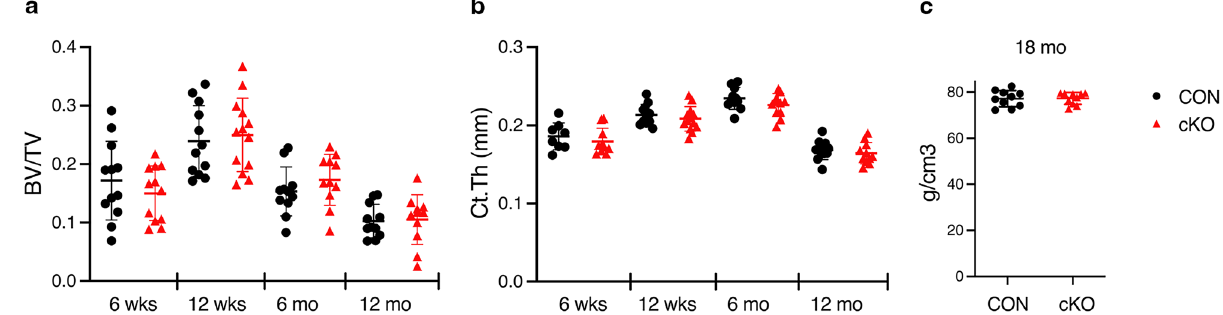
Figure 1. IKKα cKO mice have similar basal bone mass compared to controls. ( a ) Cancellous bone volume fraction (BV/TV) or ( b ) Cortical thickness (Ct.Th) of tibiae at 6 wks (n = 12), 12 wks (n = 11–13), 6 mo (n = 11), 12 mo (n = 11) by in vivo microCT. ( c ) Whole body bone mineral density by dual-energy x-ray absorptiometry (DXA) for 18–20 mo mice (n = 11). Data are represented as mean ± SD. CON = black circles, cKO = red triangles, all male mice. Non-significant between genotypes at each age by student’s, unpaired, two-tailed